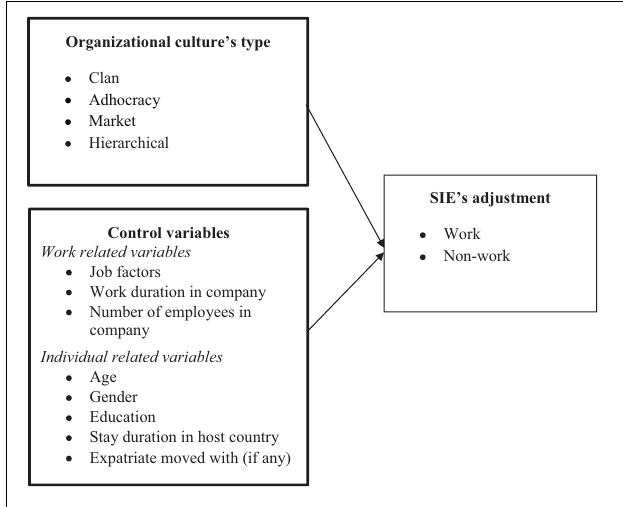
FIGURE 1 | Research